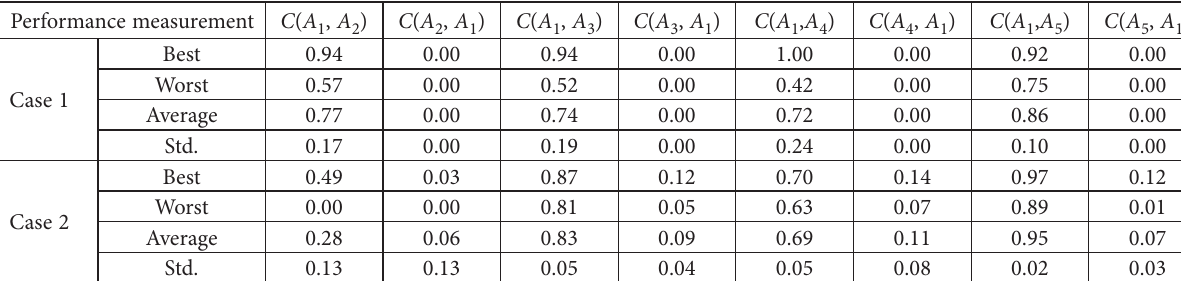
Table 3. Comparison of C-metrics for various algorithms Performance